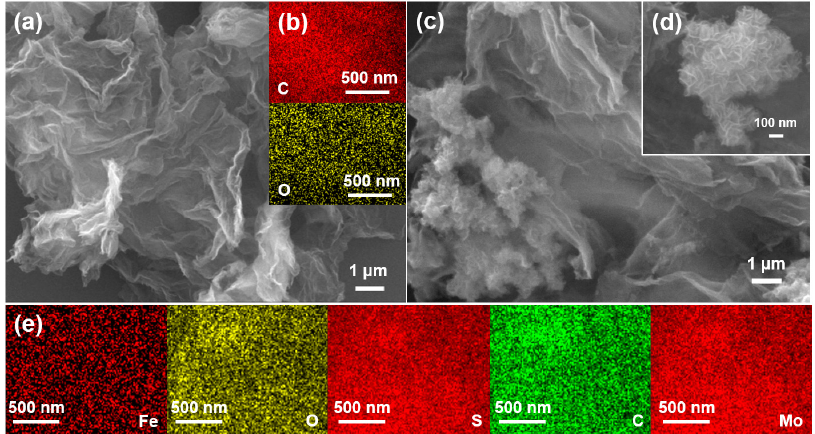
Figure 1. SEM spectra of catalysts of ( a ) rGO and ( c , d ) Fe-Mo/rGO; EDS elemental mappings of catalysts of ( b ) rGO and ( e ) Fe-Mo/rGO. catalysts of ( b ) rGO and ( e )